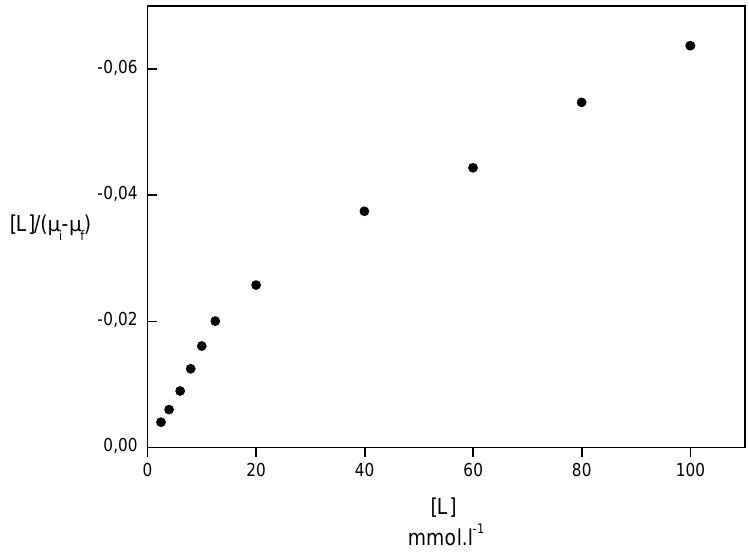
Fig. 2. The plot for determination of the association constant of TB- α -CD with BG 463.